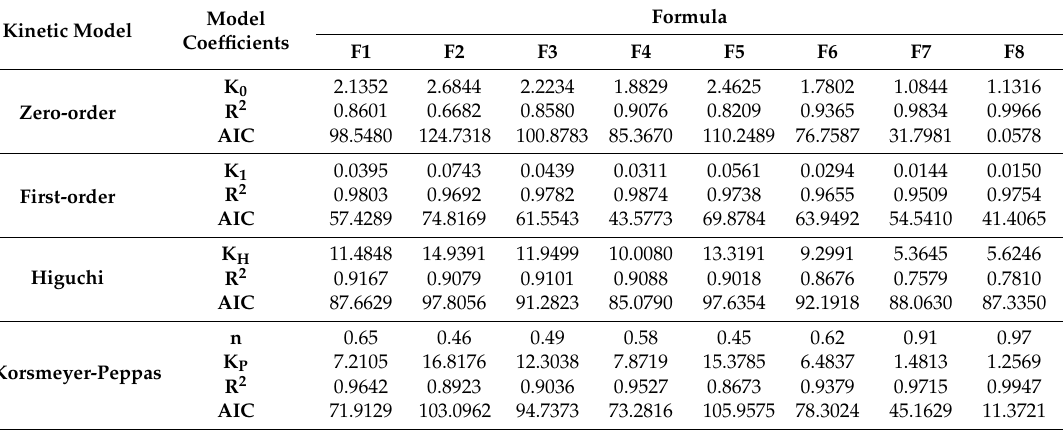
Table 4. Results of curve fitting of in vitro AL release profile from AL-loaded SLPs in phosphate buffer